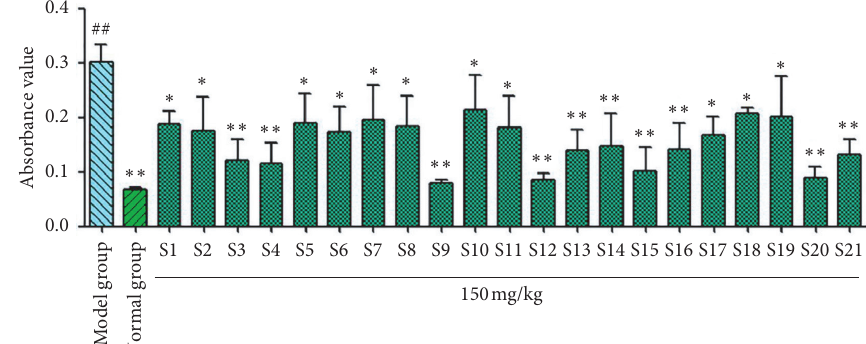
Figure 4: Results of tracheal phenol red of flavonoids in Glycyrrhiza uralensis Fisch. from 21 producing areas. The result represents mean ± S.D. Note. Compared with the normal group, ## P < 0 . 01 is a very significant difference. Compared with the model group, ∗ P < 0 . 05 was considered as significant difference; ∗ ∗ P < 0 . 01, and there was a significant difference ( n � 10).